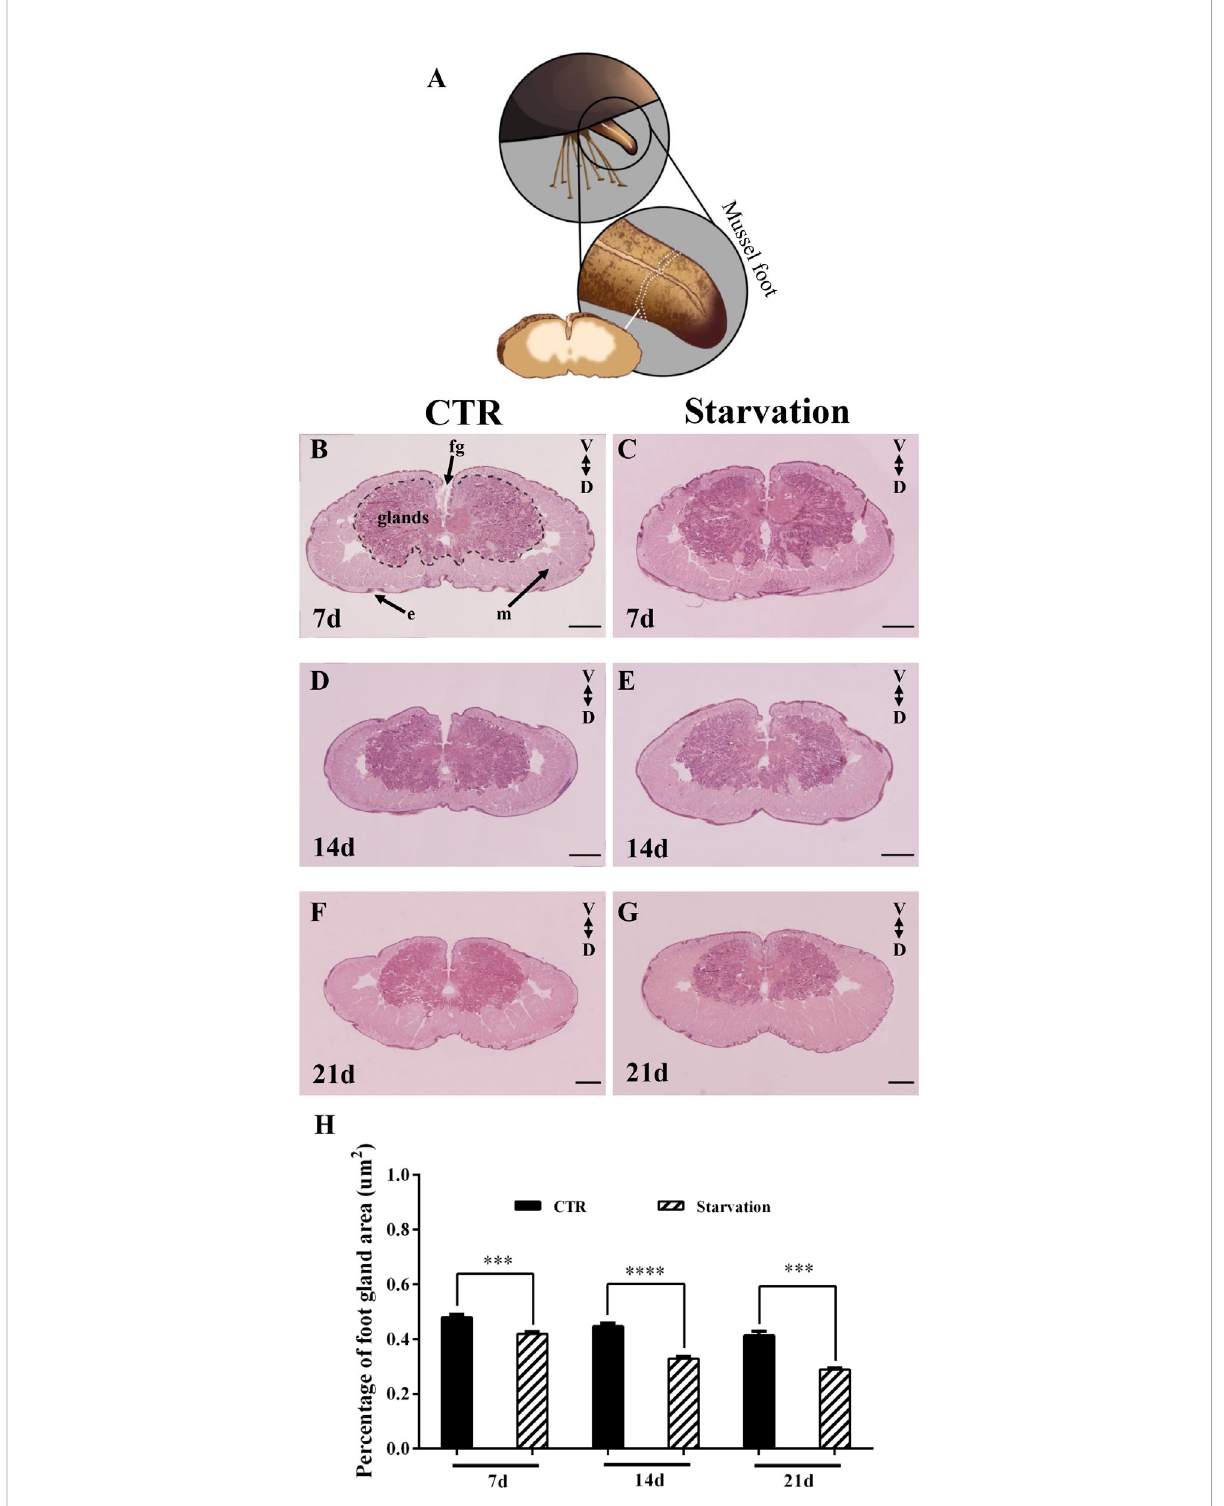
FIGURE 4 The foot of M. coruscus stained with hematoxylin and eosin (H&E). (A) A schematic depiction of foot section sampling. (B) 7d CTR, (C) 7d starvation, (D) 14d CTR, (E) 14d starvation, (F) 21d CTR, (G) 21d starvation. (H) The percentage of foot gland area versus total foot tissue. CTR: control group; fg: foot groove; m: muscle; e: epidermis; V: ventral; D: dorsal. Scale bar = 500 m m. Asterisks indicate signi fi cant differences between starvation groups and CTR groups. *** p < 0.001; **** p <